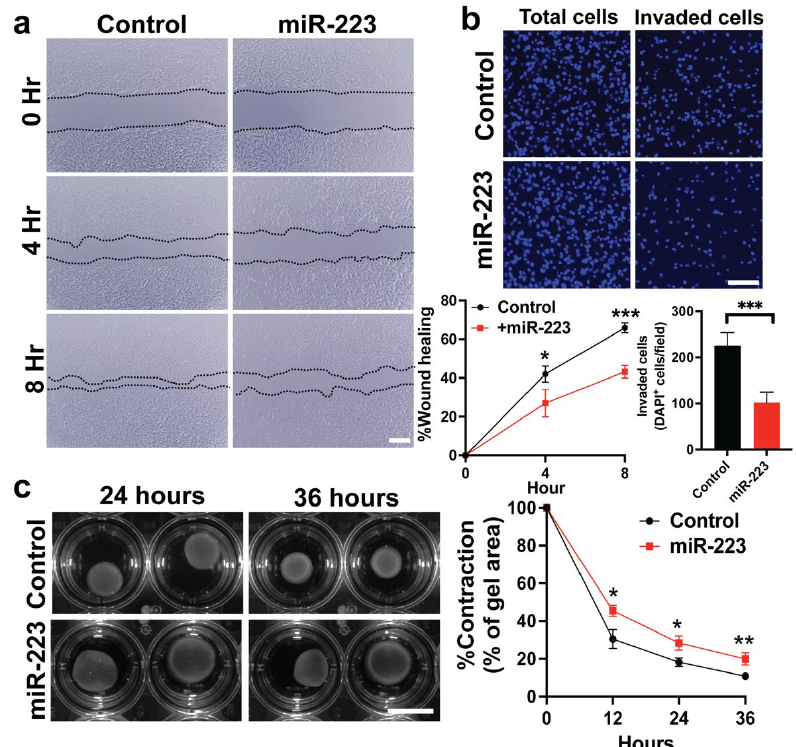
Figure 3. miR-223 suppresses migration, invasion, and contractility of primary human HSCs. ( a ) Representative images of scratch assay to determine ability for wound closure of control and miR-223 HSCs at different time points. Dash lines indicate the border of migration. ( b ) Representative fluorescent images of nuclear DAPI staining indicated invaded cells after seeding in a Matrigel- coated Transwell for 24 h with chemoattractant (2% FBS). Invaded cells were counted from 10 ran- dom microscope fields for each group. ( c ) Representative images of collagen matrix contraction at 24 and 36 h after the lattices were dislodged. Gel contraction was measured at 12 h intervals as indicated. Data presented as the mean ± SD. N = 3–4 replicates from at least two independent exper- iments. Student’s t -test; * = p < 0.05, ** = p < 0.01 and *** = p < 0.001. Scale bars, 200 μm ( a ), 100 μm ( b ), and 5 mm ( c ). DAPI: 4′,6 -diamidino-2-phenylindole.